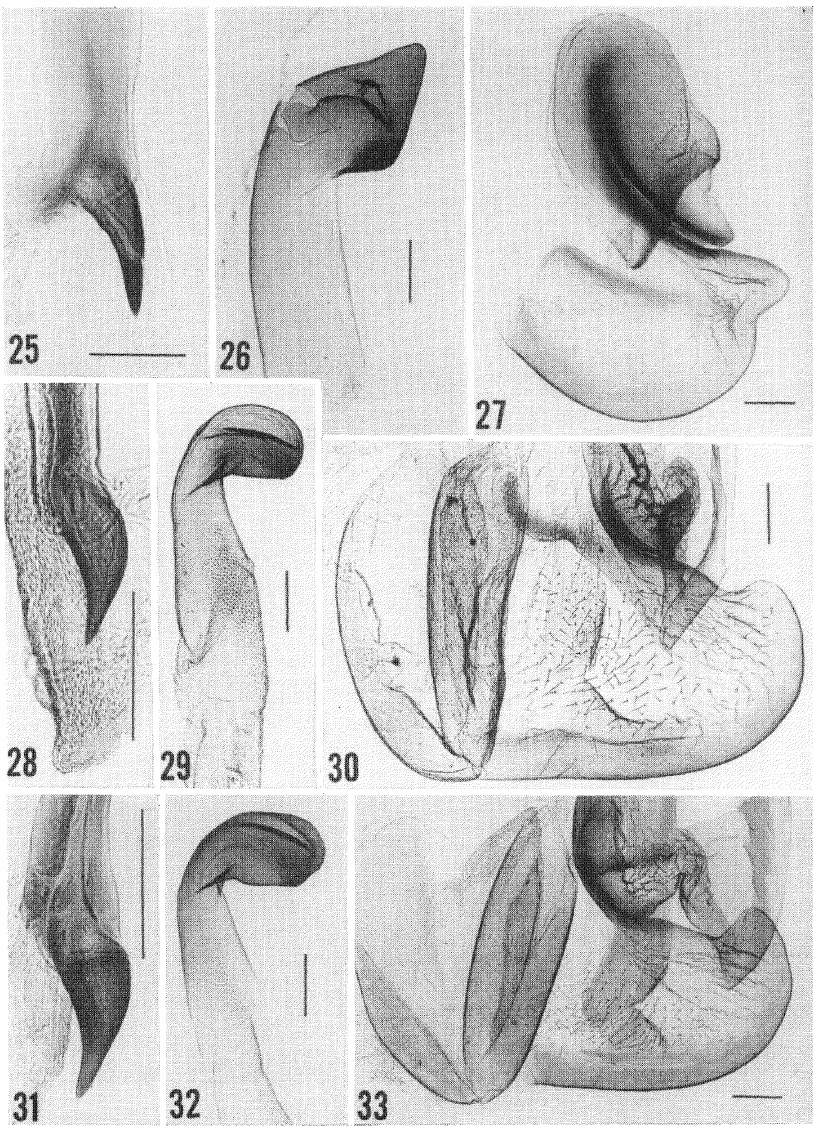
Figs. 25-33. Poeci!oderrhis spp. 25-27. (12, BMNH). P. ferruginea. Rio de Janeiro, Organ Mts. near Tijuca, Brazil. (det. Princis). 28-33. Poeciloderrhis sp. /. 28-30. (72, MCZ). Annapolis, Goias, Brazil; tergal gland in Fig. 40. (det. Roth). 31-33. (109, ANSP). "Vlannopolis", Goias, Brazil. (det. Roth). (scale 0.2